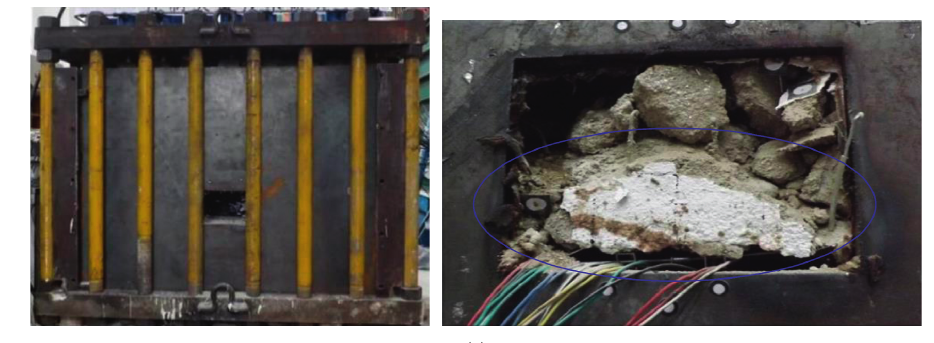
Figure 11: The experiment validation of oblique section failure of thin immediate roof under uniform load. (a) The test device and the failure of the thin immediate roof in the literature [20]. (b) The test device and the failure of the thin immediate roof in the literature [1]. (c) The roof collapse of the Great Wall Number #3 coal mining field.